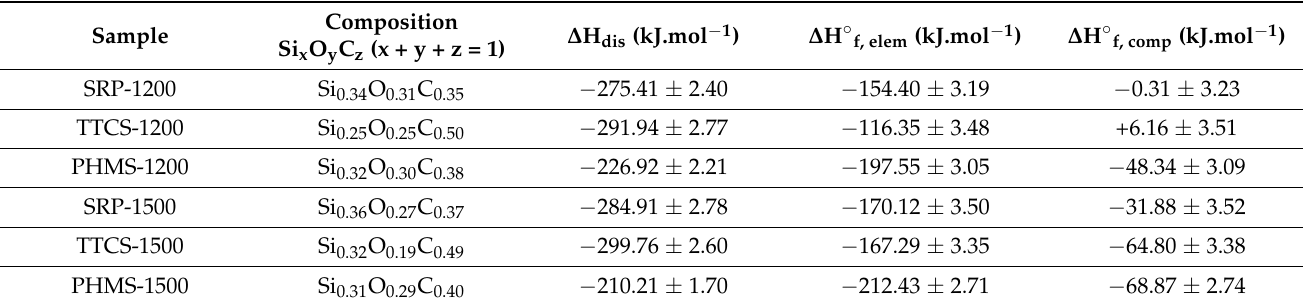
Table 3. Summary of enthalpies of formation from elements ∆ H ◦ f, elem and components ∆ H ◦ f, comp using composition from XPS.